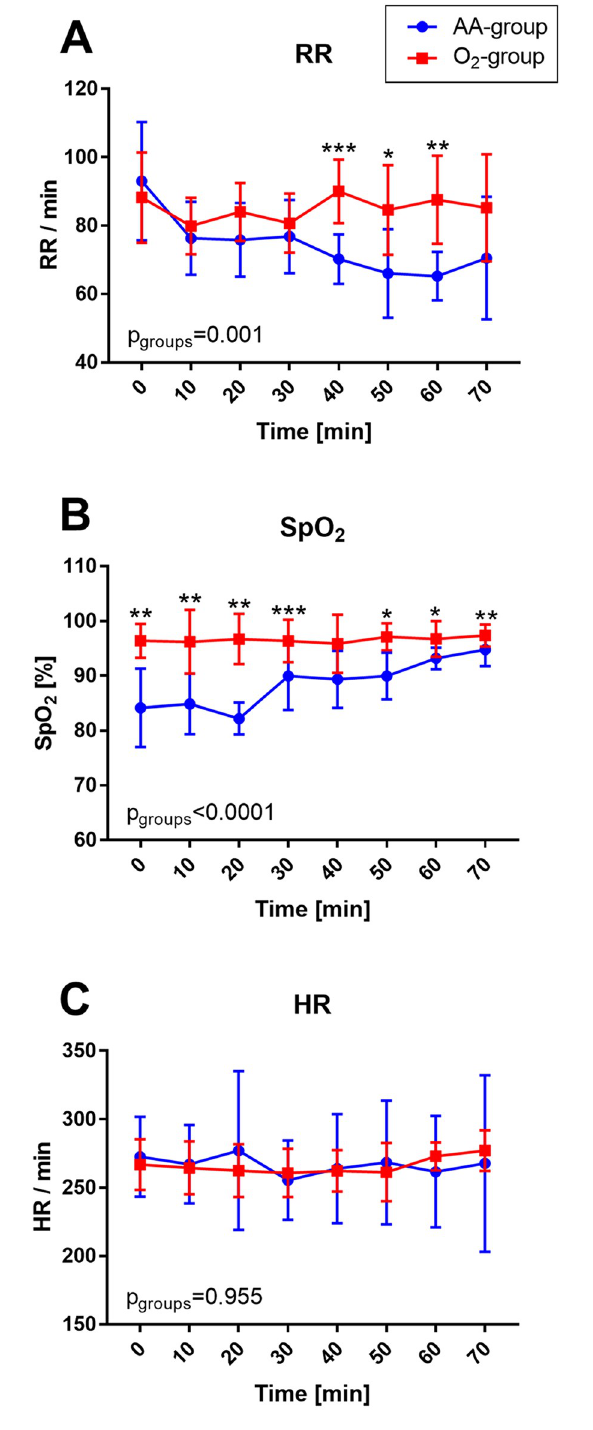
Fig 2. Intraoperative time course of (A) respiratory rate (RR), (B) oxygen saturation (SpO 2 ) and (C) heart rate (HR) of male Sprague Dawley rats under KX anaesthesia depending on the additional oxygen supply. Rats in the ambient air (AA) group only breathed ambient air whereas rats in the oxygen (O 2 ) group had an increased oxygen supply intra- and postoperatively. The graphs show significantly increased saturation values in the O 2 group and significantly higher respiratory rates after 40 minutes of anaesthesia compared to the AA group. No group differences are visible in heart rate. Symbols mark significant differences between groups at the time points ( � < 0.05; �� < 0.005; ��� < 0.0005; ���� < 0.0001).